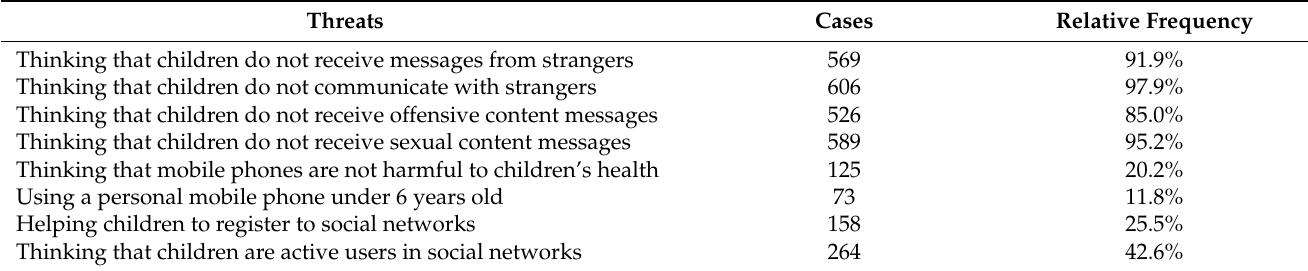
Table 2. Distribution of the respondents by possible threats to children caused by the usage of their personal mobile phones ( n =